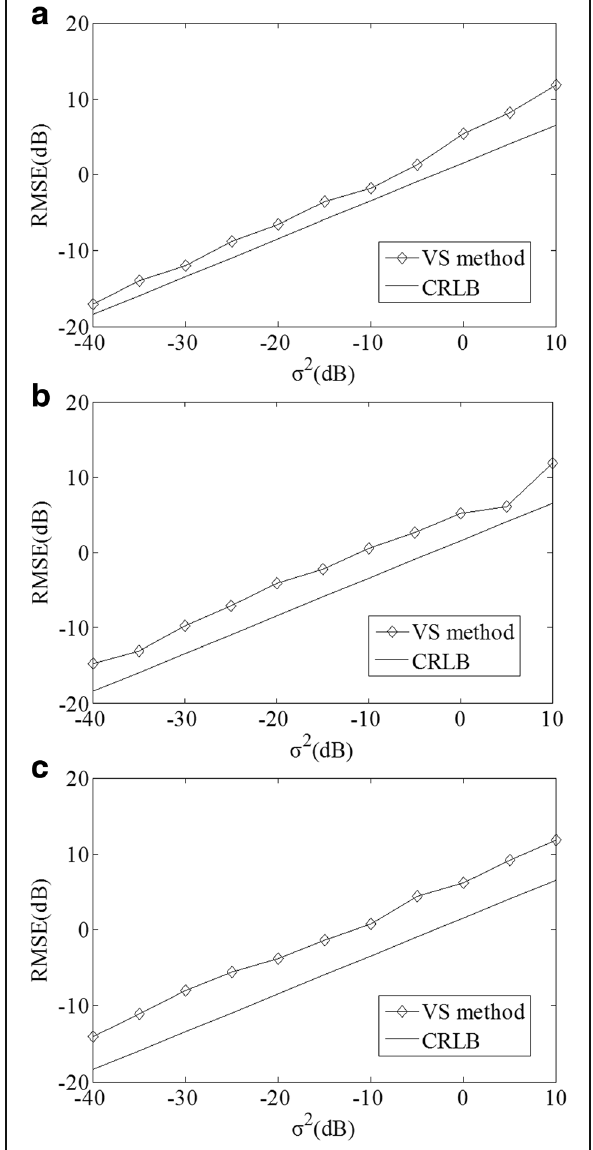
Fig. 3 CRLB of the VS method. a Point A. b Point B. c Point